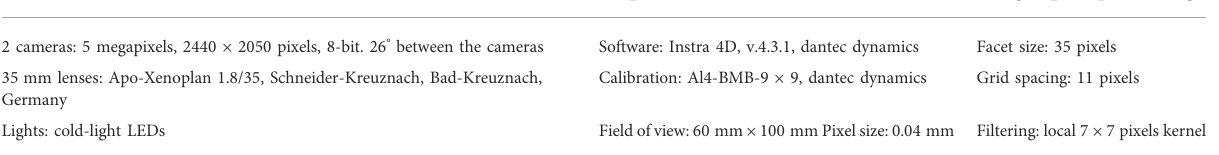
TABLE 2 Material and parameters of the DIC system.